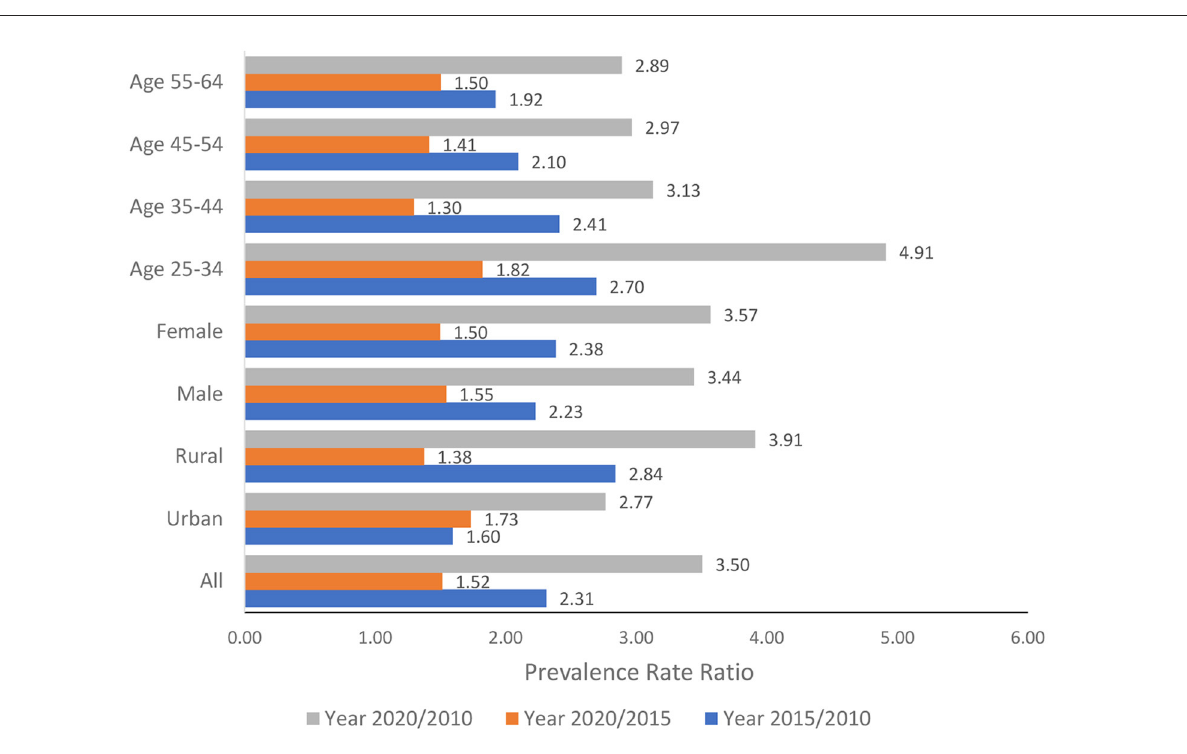
FIGURE4 Relative changes in the prevalence of elevated blood lipids over